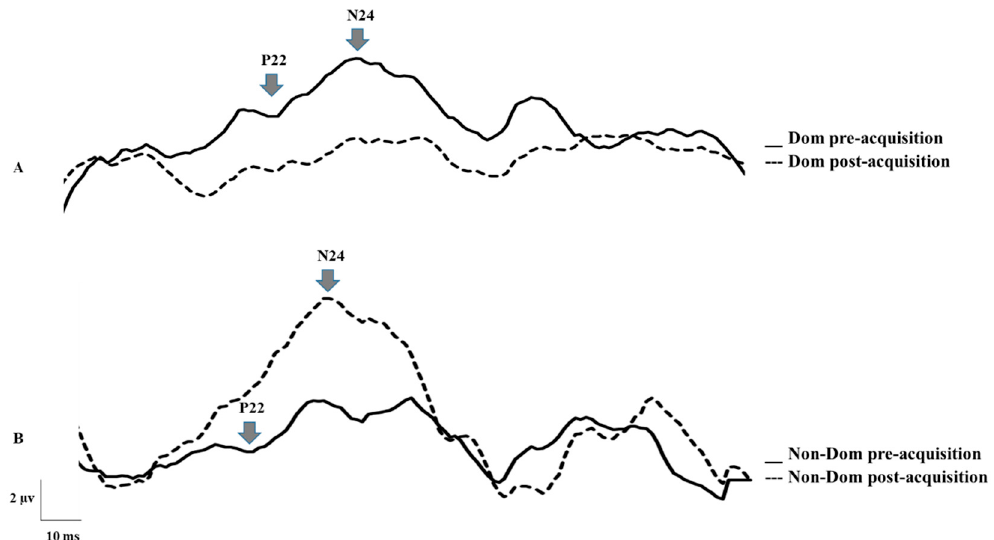
Figure 4. Raw data from an average 1500 sweeps of the waveforms of two representational participants. Pre- and post-motor acquisition N24 SEP peak amplitudes for: ( A ) Dom hand and ( B ) Non-Dom hand.